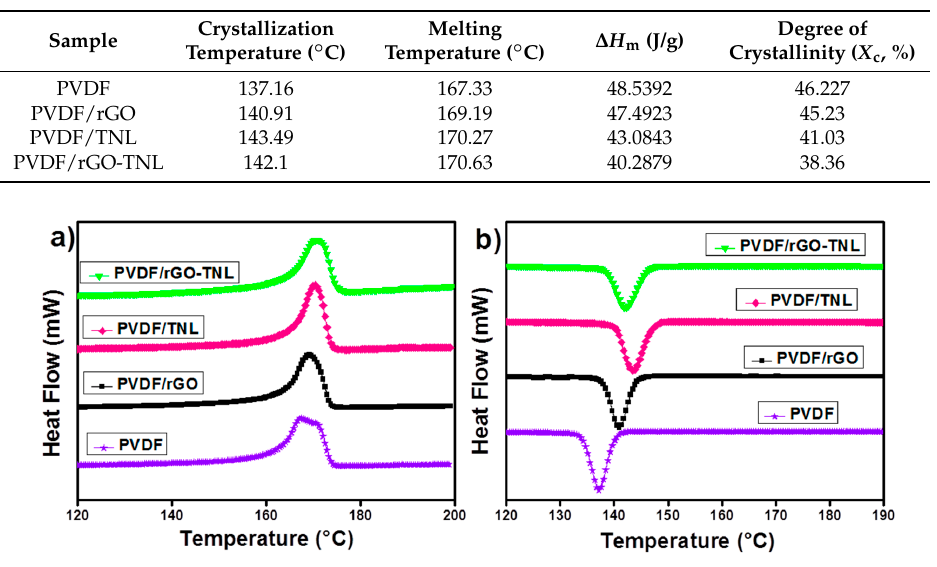
Table 3. DSC data of PVDF/rGO-TNL, PVDF/rGO, PVDF/TNL, and PVDF.